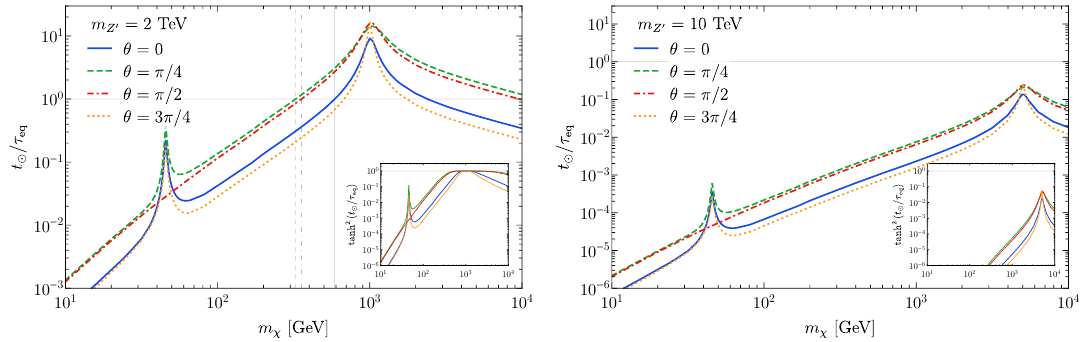
Figure 6 . Ratio of the age of the Sun over the timescale for the reach of equilibrium between capture and annihilation of DM, for m Z 0 = 2 TeV ( left ) and 10 TeV ( right ). The ratio t (cid:12) =(cid:28) eq scales as (cid:3) (cid:0) 4